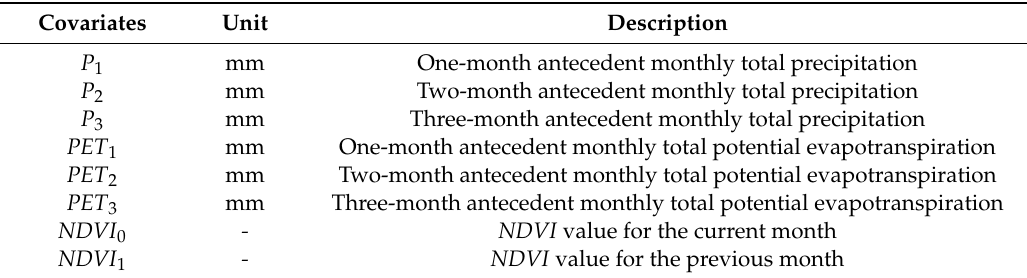
Table 2. Description of external covariates for time-varying